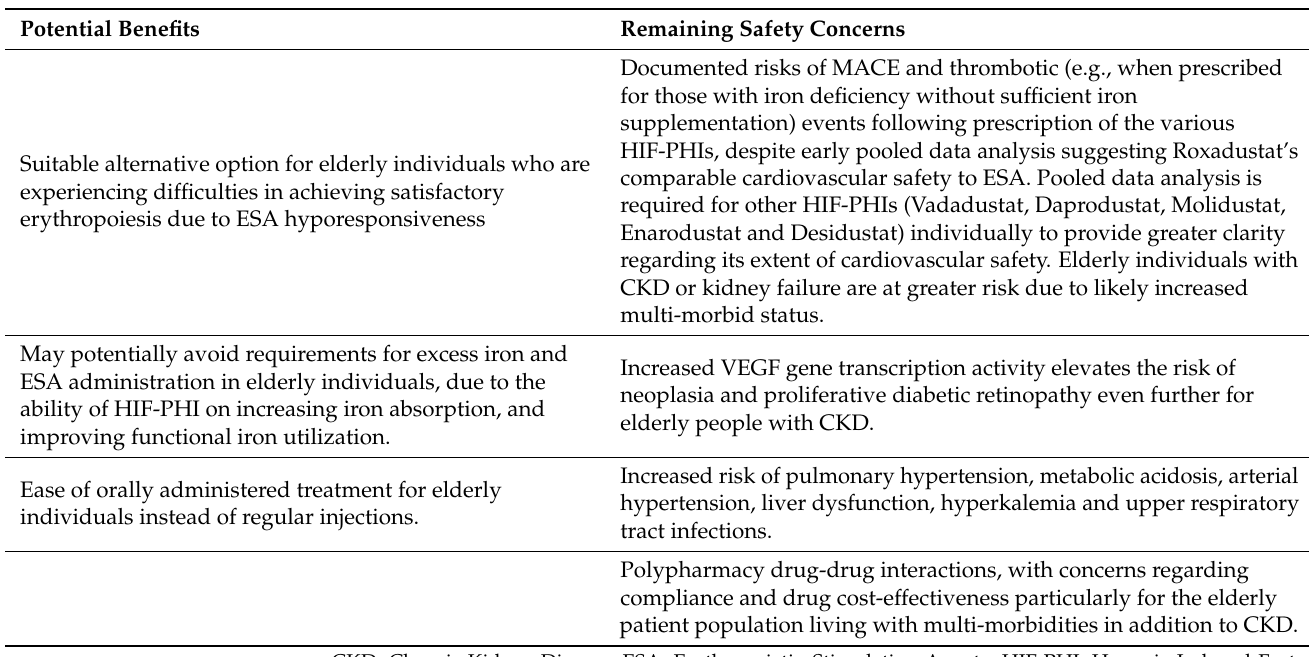
Table 1. Potential benefits and remaining safety concerns of HIF-PHI prescription for elderly patients with CKD and